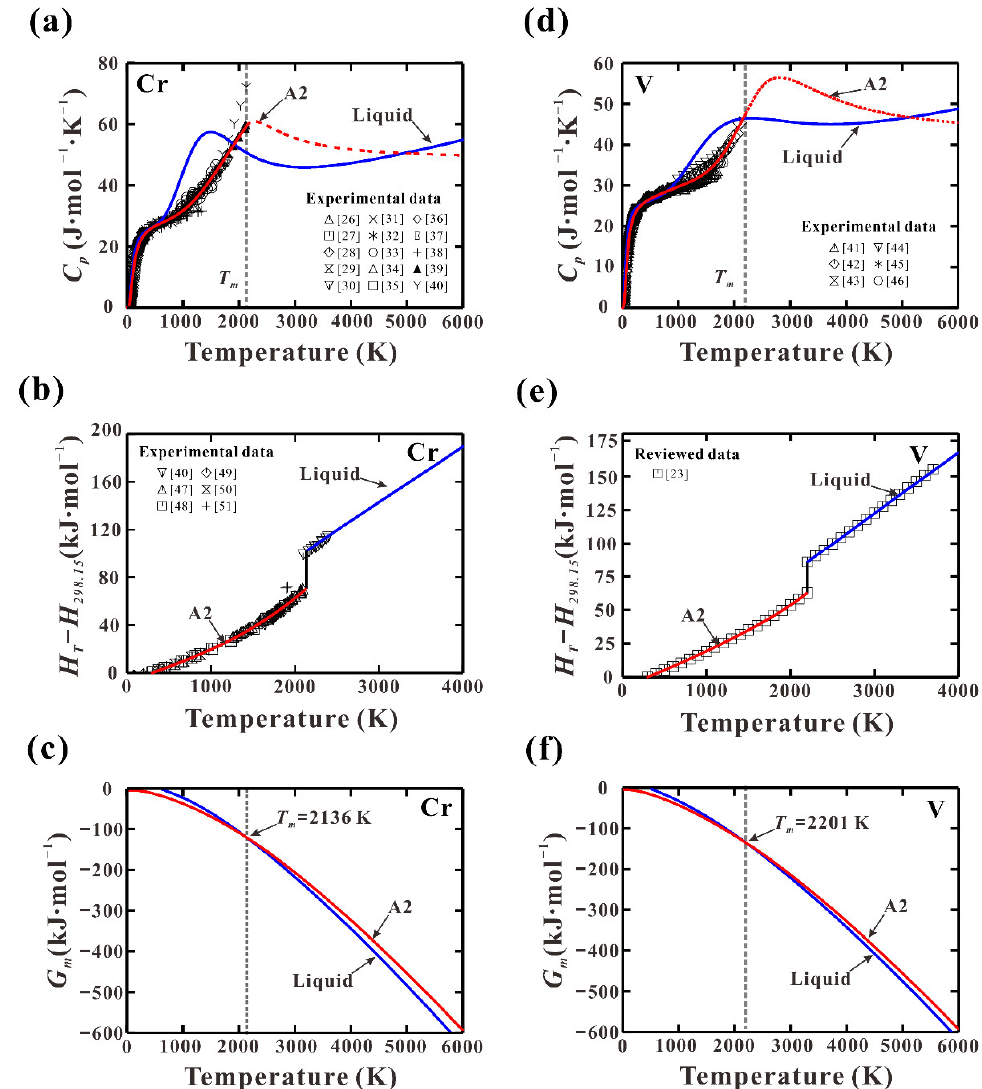
Figure 1. Calculated thermodynamic properties: ( a , d ) heat capacity ( C p ); ( b , e ) heat content ( H T – H 298 ); ( c , f ) molar Gibbs energy of pure Cr and V in comparison with reported data [23,26–51].